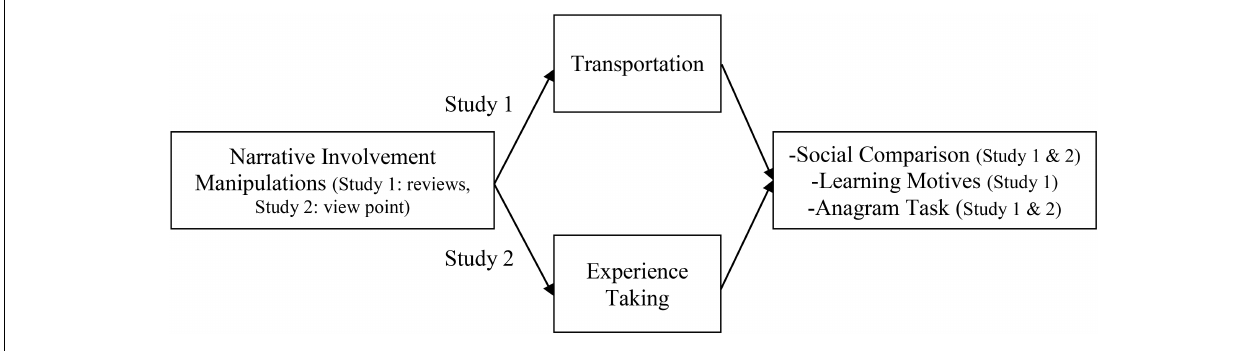
FIGURE 1 | Proposed model of assimilation vs. contrast effects for both